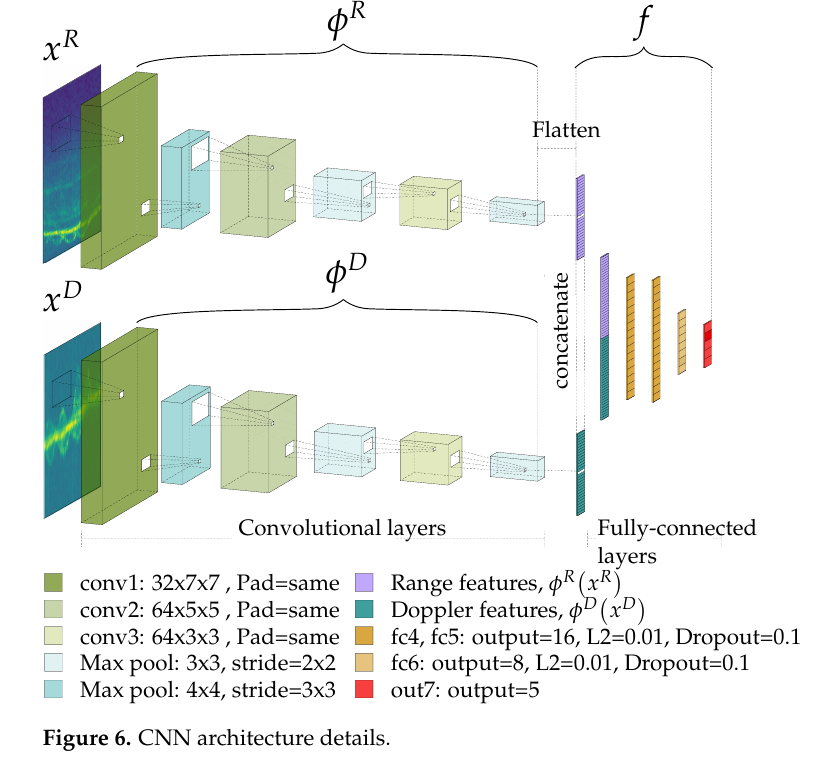
Figure 6. CNN architecture details.